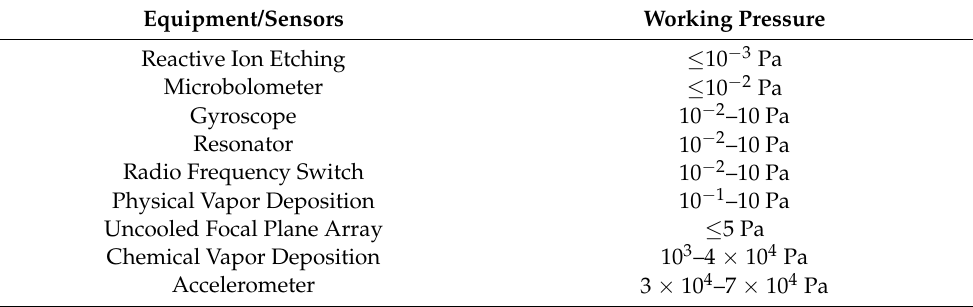
Table 2. Pressure requirements for different equipment or